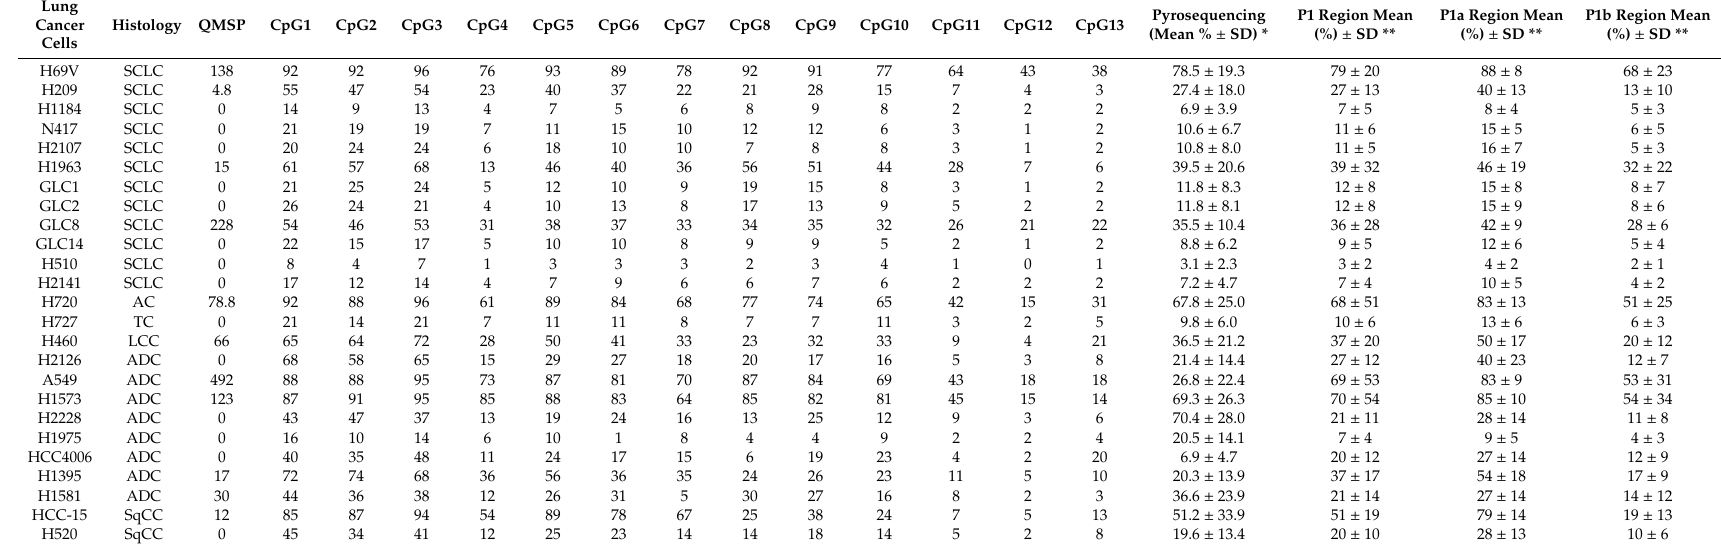
Table 1. KEAP1 P1 promoter methylation levels assessed by QMSP and